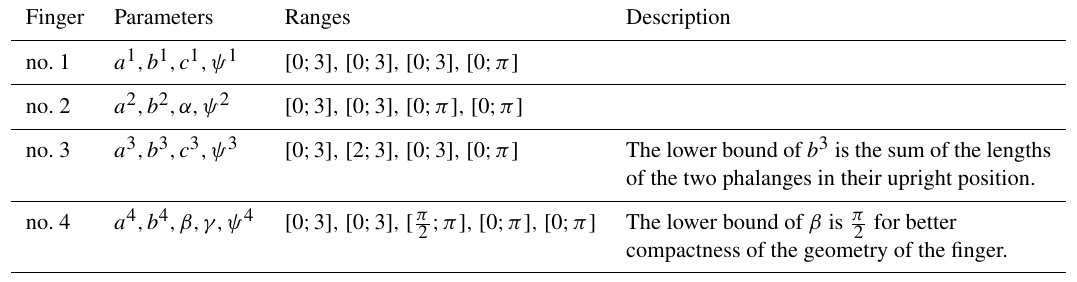
no. 4 a 4 ,b 4 ,β,γ,ψ 4 [ 0 ; 3 ] , [ 0 ; 3 ] , [ π